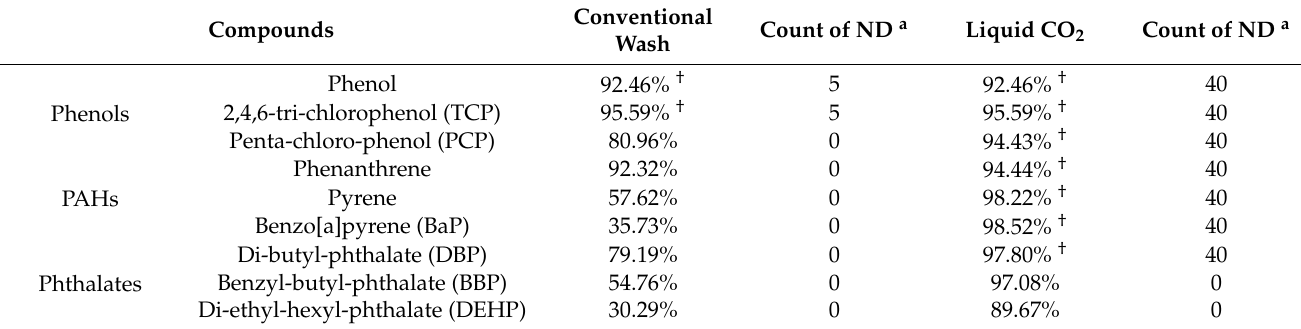
Table 5. Average washing efficiency of targeted contaminants for conventional and liquid CO 2